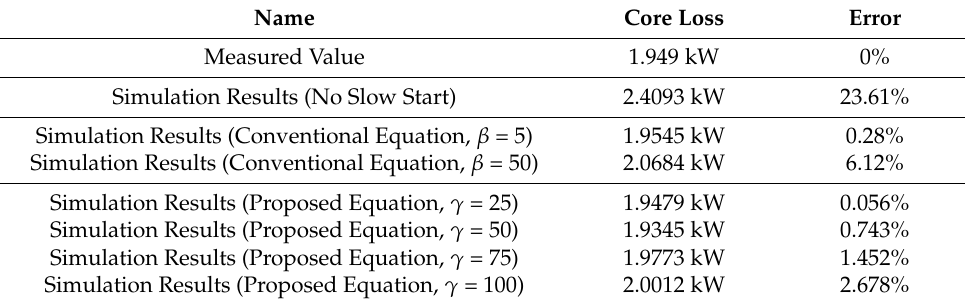
Table 7. Experimental results of the core